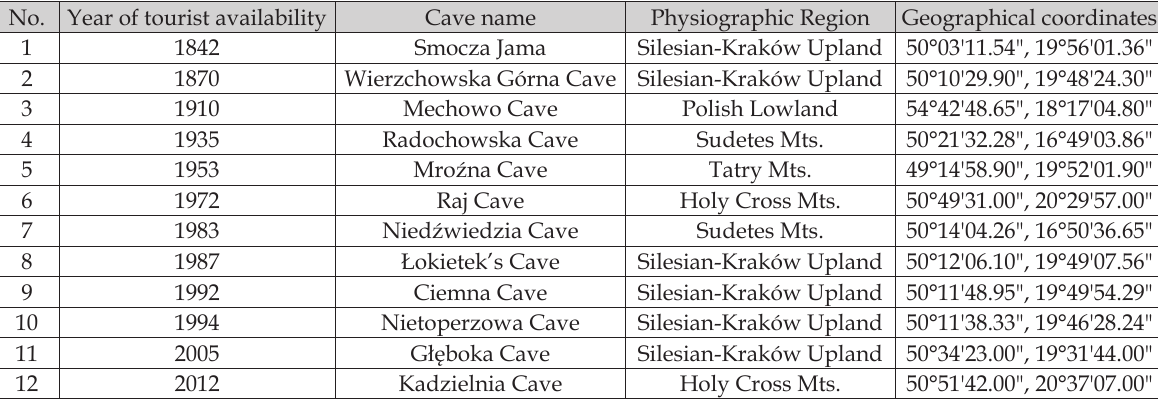
Table 1. Show caves according to the order in which the caves are made available to